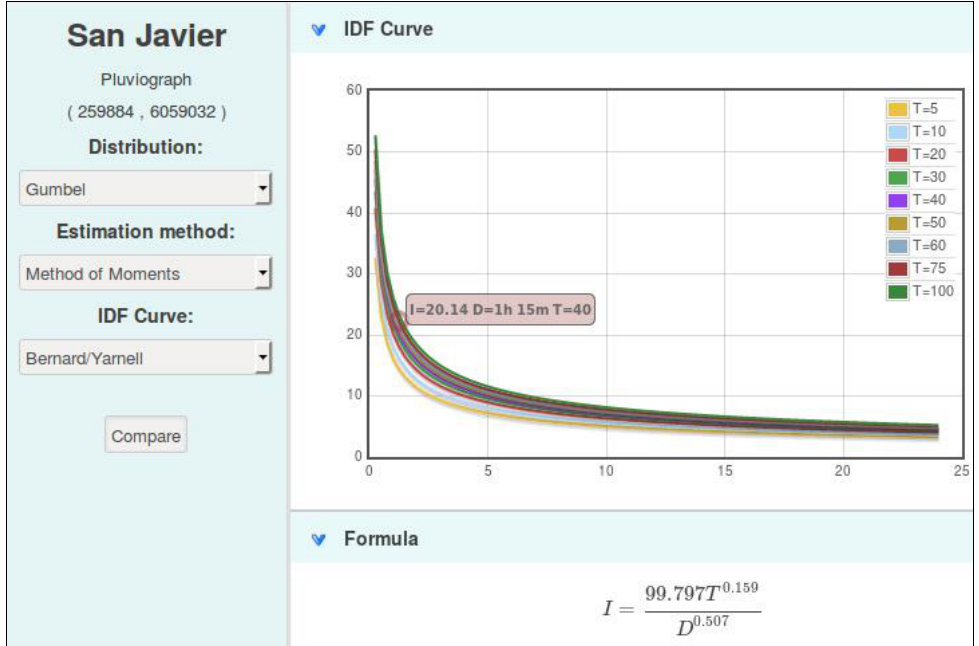
Figure 9. Graphic visualization of IDF curves and IDF model for a pluviograph gauge (San Javier City) included in WEBSE IDF.